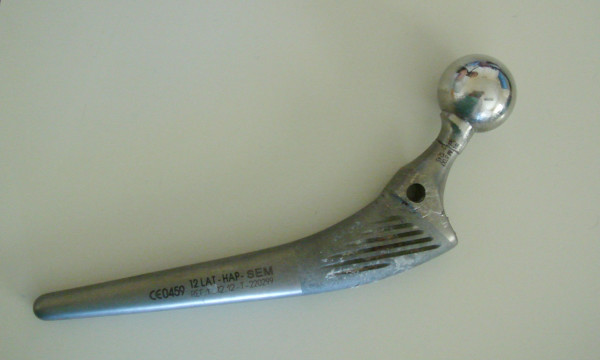
The retrieved stem.